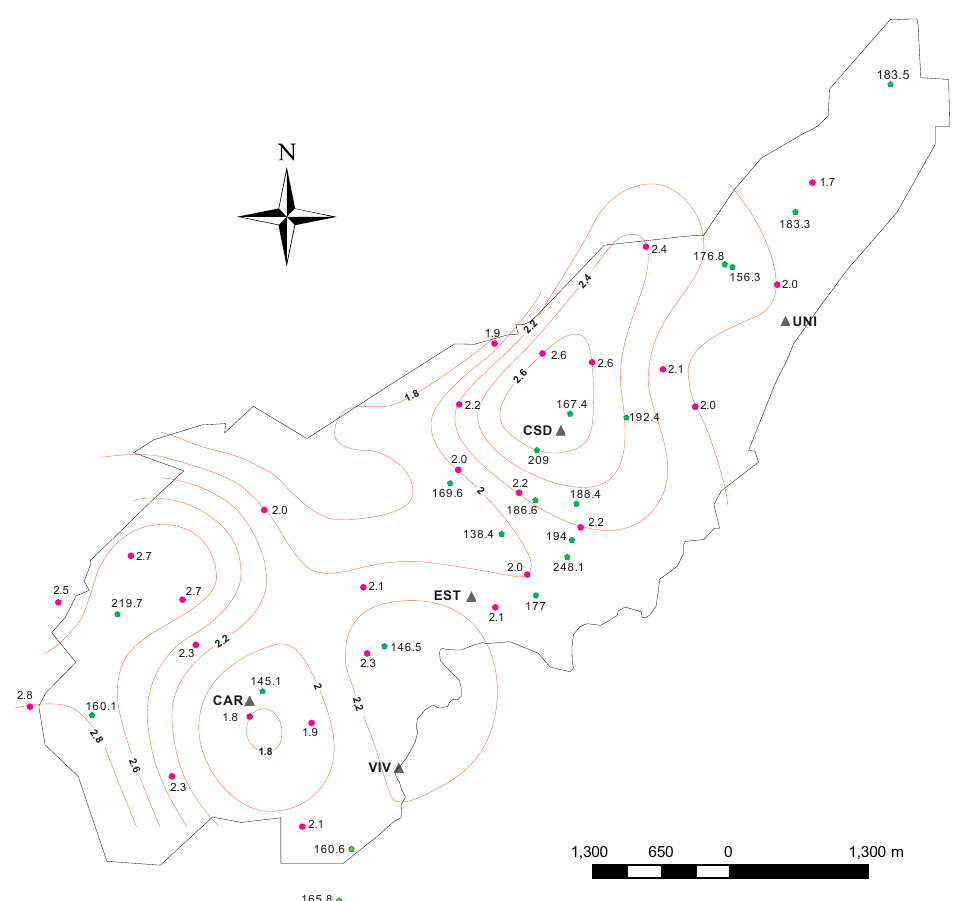
Figure 13. Spatial distribution of the fundamental frequency in Hz (red lines). The black line shows the city of Armenia. Red circles show locations of ambient noise measurements in 2002 together with their fundamental frequency value. Solid triangles show the stations that recorded aftershocks of the 1999 event. Green symbols mark seismic cone measurements, with their average shear wave velocity.